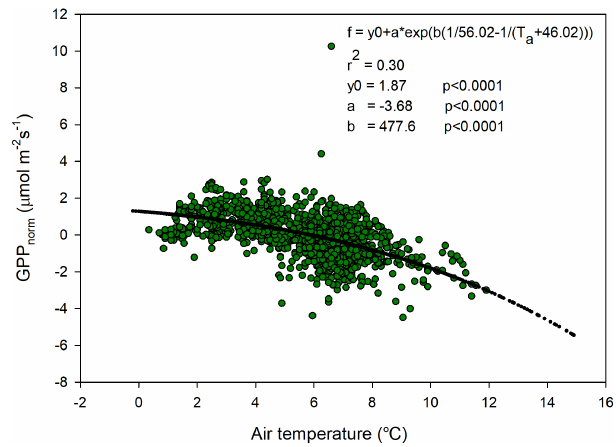
Figure 10. Normalized gross primary productivity (GPP) plotted against air temperature and with the fitted exponential model.